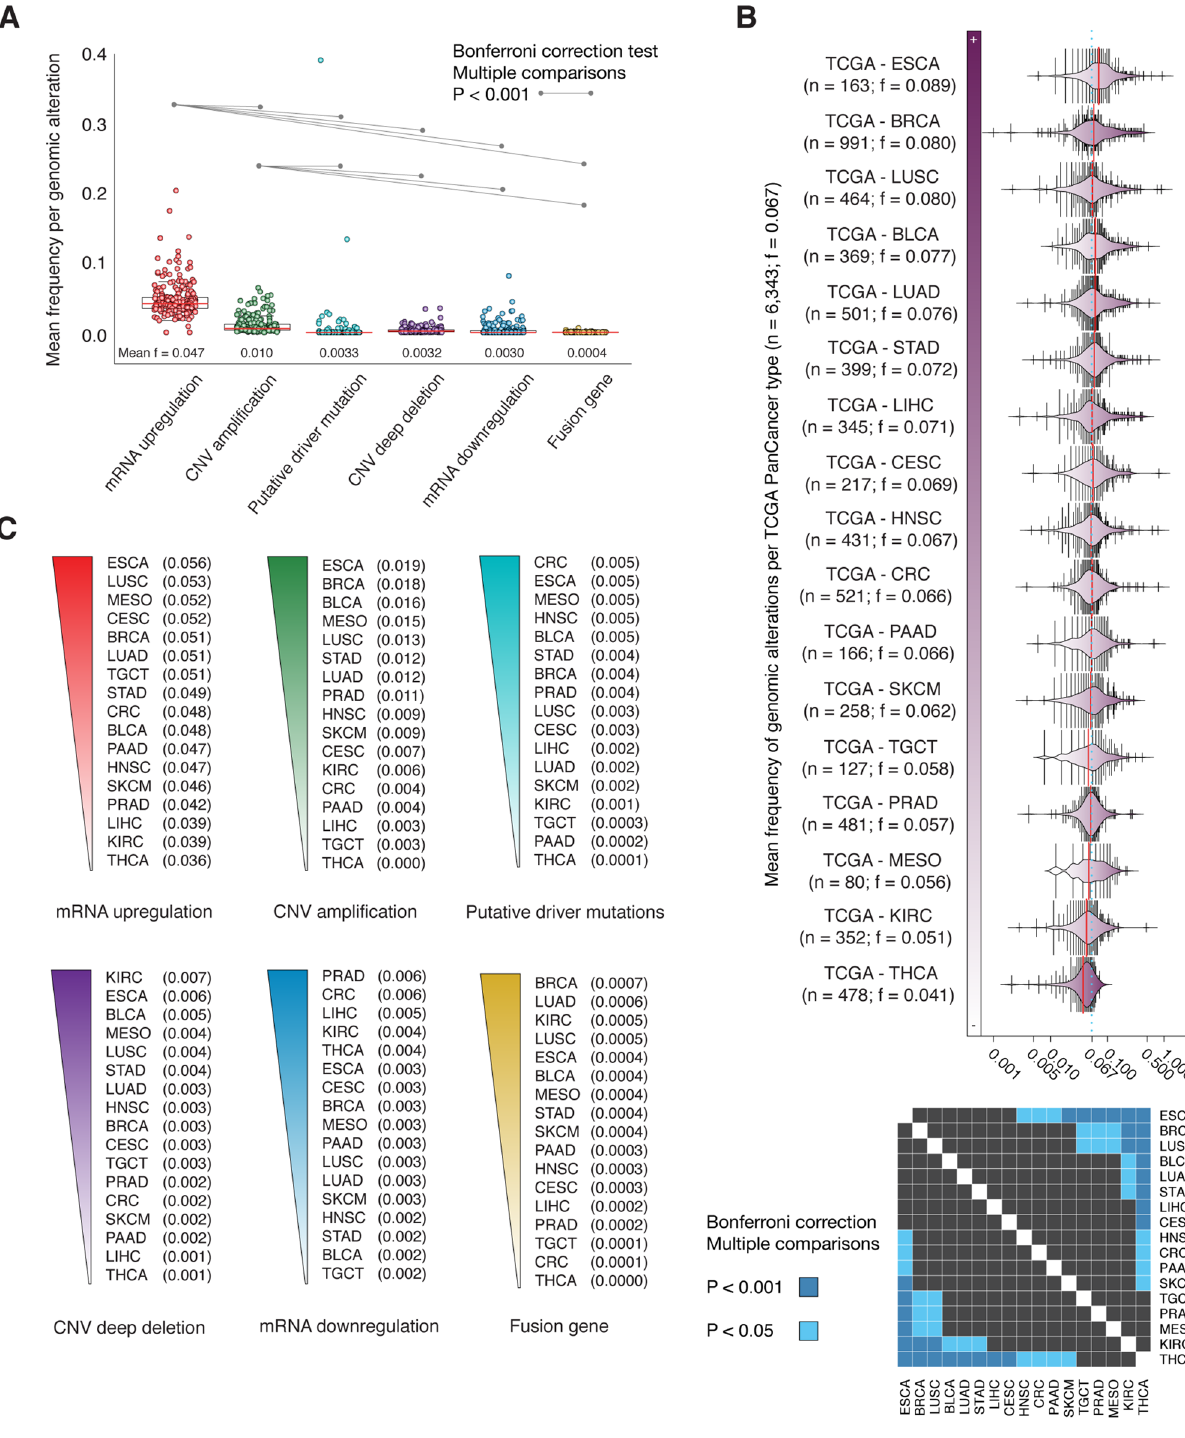
Figure 2. Frequency of genomic and transcriptomic alterations per PCA-TCGA type. ( A ) Mean frequency per alteration type and significant Bonferroni correction ( P < 0.001) of mRNA upregulation, CNV amplification, putative driver mutation, CNV deep deletion, mRNA downregulation, and fusion gene in comparison with other alterations. ( B ) Ranking of the most altered pancarcinomas from PCA-TCGA according to the mean frequency of alterations, and its validation with a pairwise map of significant Bonferroni correction across PCA-TCGA. ( C ) Ranking of the most altered pancarcinomas per alteration type. TCGA: The Cancer Genome Atlas; BLCA: bladder urothelial carcinoma; BRCA: breast invasive carcinoma; CESC: cervical squamous cell carcinoma and endocervical carcinoma; CRC: colorectal adenocarcinoma; ESCA: esophageal carcinoma; HNSC: head and neck squamous cell carcinoma; KIRC: kidney renal clear cell carcinoma; LIHC: liver hepatocellular carcinoma; LUAD: lung adenocarcinoma; LUSC: lung squamous cell carcinoma; MESO: mesothelioma; PAAD: pancreatic adenocarcinoma; PRAD: prostate adenocarcinoma; SKCM: skin cutaneous melanoma; STAD: stomach adenocarcinoma; TGCT: testicular germ cell tumors; THCA: thyroid carcinoma; CNV: copy number